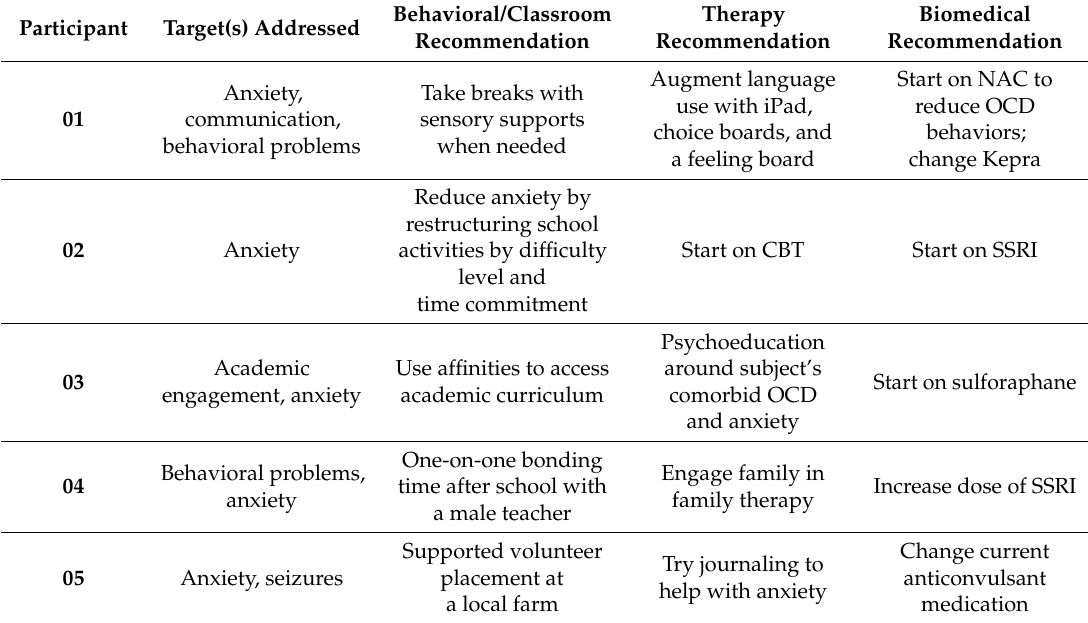
Table 2. Examples of recommendations across different domains during the case